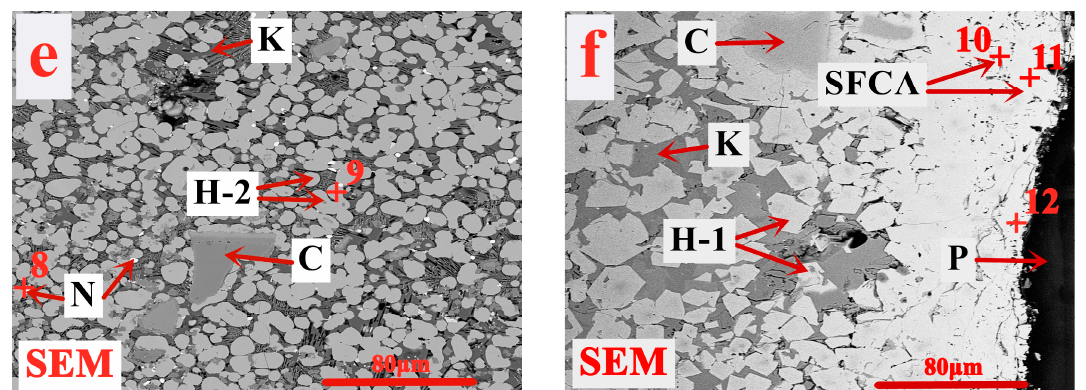
Figure 9. Microstructure of product sinter (A) of traditional sintering process (H—(Fe, Mg) · (Fe, Al) 2 O 4 , H-1—Fe(Fe, Al) 2 O 4 , H-2—(Fe, Mg)Fe 2 O 4 , K—CaO · (Fe, Mg) Al 2 O 4 · SiO 2 , K-1—CaO · FeAl 2 O 4 · SiO 2 ,